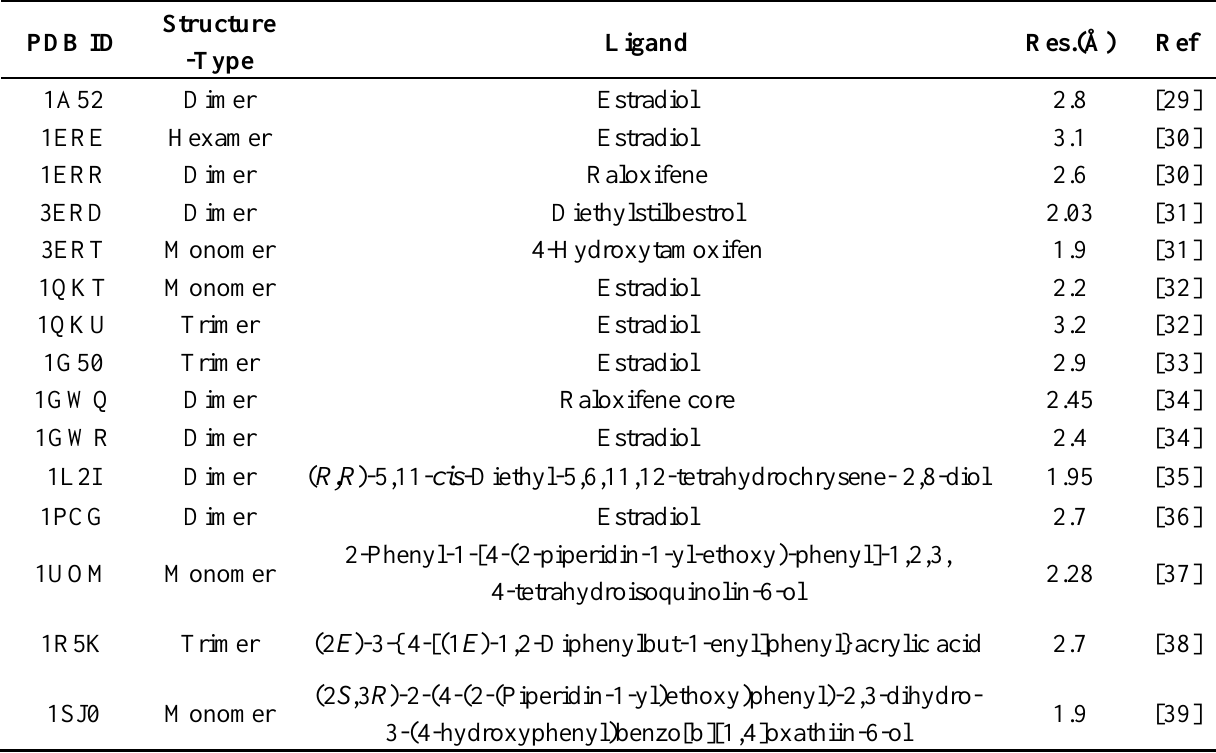
Table 1. Crystal structures of ERα ligand binding domain bound with ligands in